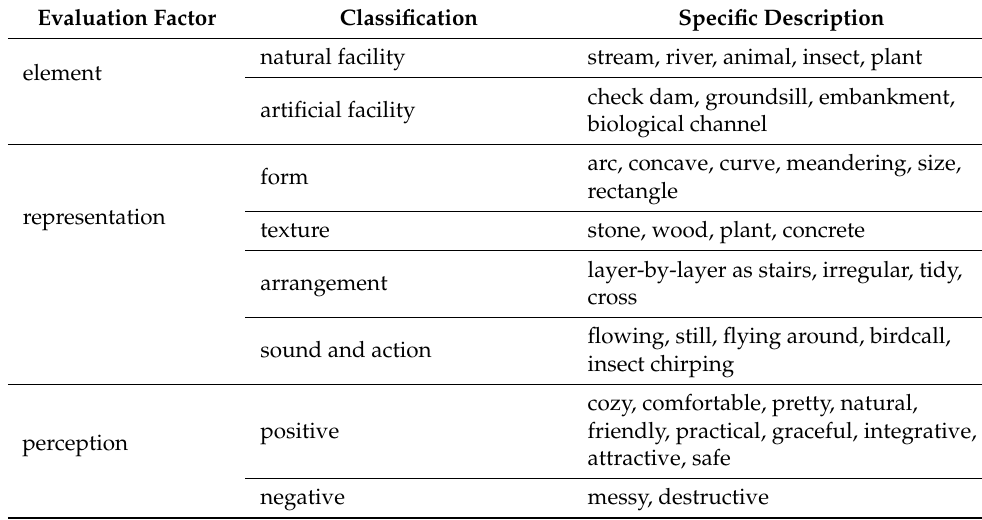
Table 7. Evaluation factors of element, representation, and perception.